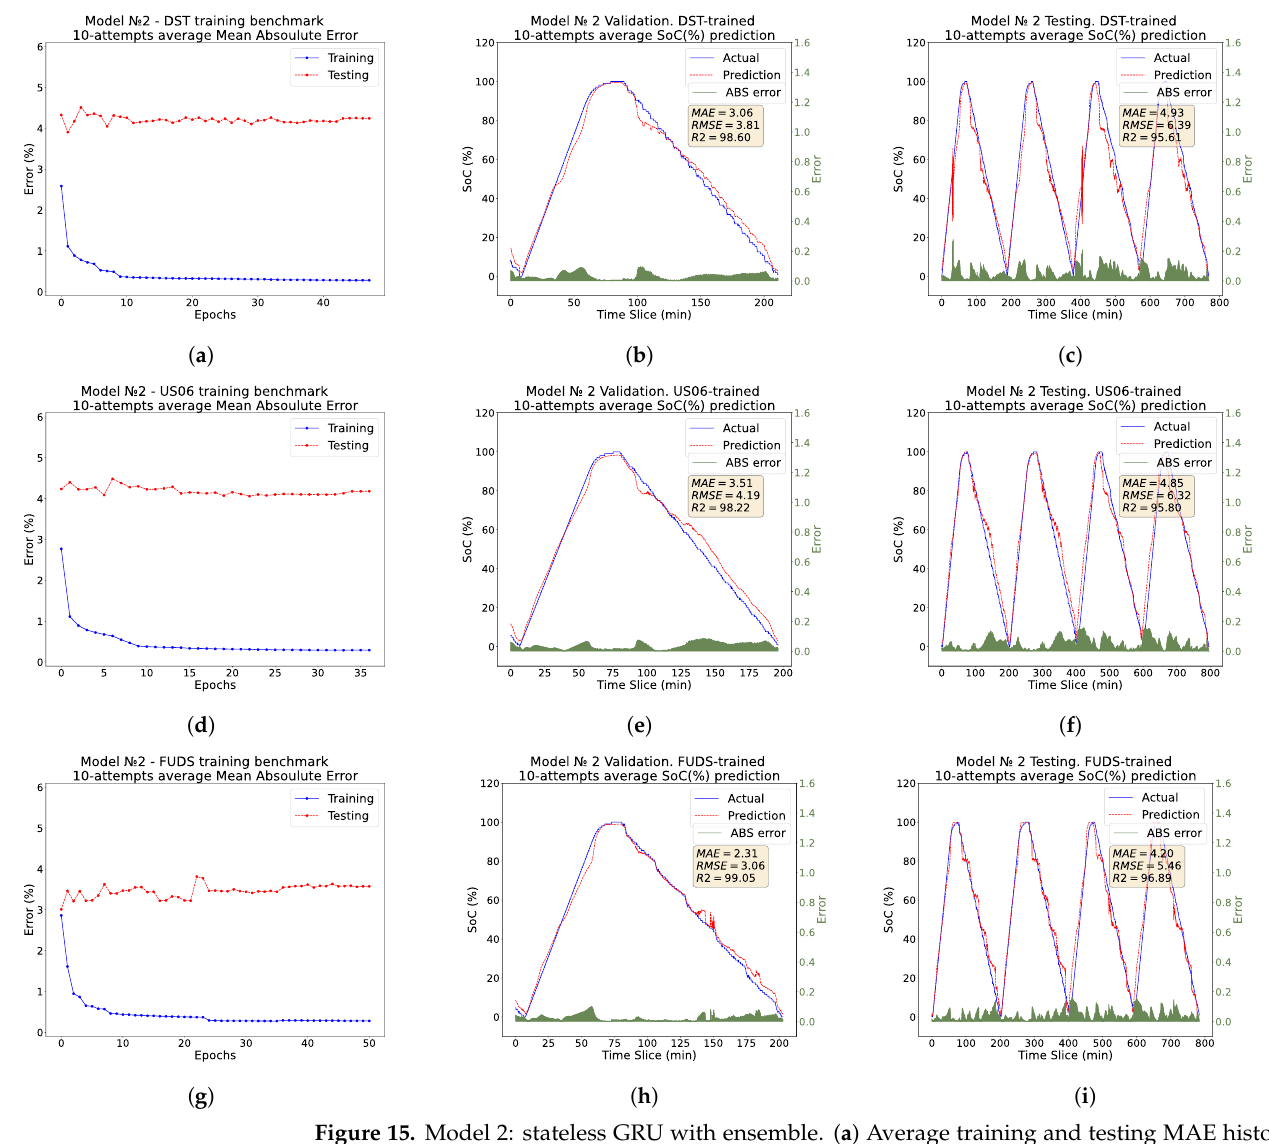
Figure 15. Model 2: stateless GRU with ensemble. ( a ) Average training and testing MAE history; average of 10 attempts. ( b ) Validation on a single cycle of SoC estimation; average of 10 attempts at 25 °C. ( c ) Testing on two cycles of US06 and FUDS profiles; average of 10 attempts. ( d ) Average training and testing MAE history; average of 10 attempts. ( e ) Validation on a single cycle of SoC estimation; average of 10 attempts at 25 °C. ( f ) Testing on two cycles of US06 and FUDS profiles; average of 10 attempts; ( g ) Average training and testing MAE history; average of 10 attempts. ( h ) Validation on a single cycle of SoC estimation; average of 10 attempts at 25 °C. ( i ) Testing on two cycles of DST and US06 profiles; average of 10